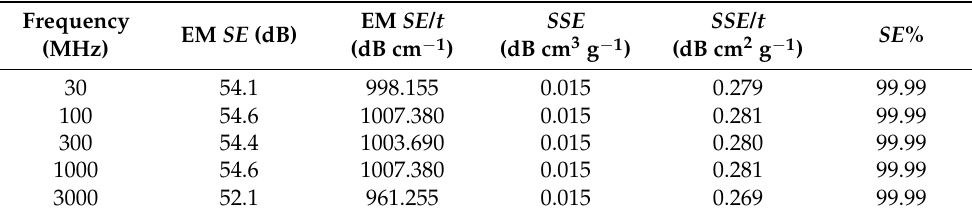
Figure 7. EM SE values versus frequency of EM curves for the Song Brocade Fabrics. Table 4. EM SE values of the sample S2 at selected